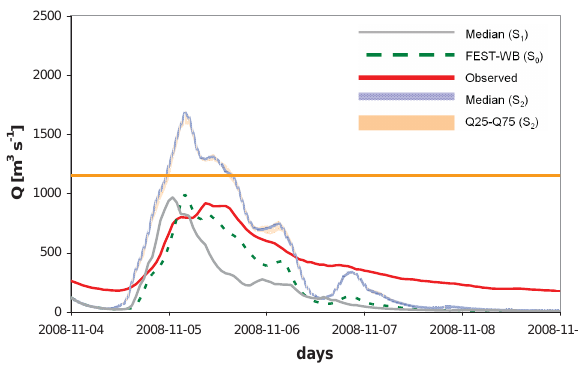
Fig. 8. QDF of the FEST-WB simulation ( S 3 ) forced with both fore- casted precipitation and temperature fields by the COSMO-LEPS model (blue line). The red line shows the observed discharge at Can- doglia and the green dashed line shows the simulated discharge on the FEST-WB ( S 0 ), forced with observed data. The grey line shows the ensemble median of the S 1 simulation, the grey dashed line il- lustrates the S 2 simulation; the hydrological simulation was initial- ized on 4 November 2008. The horizontal orange line is warning code 2 for the Toce